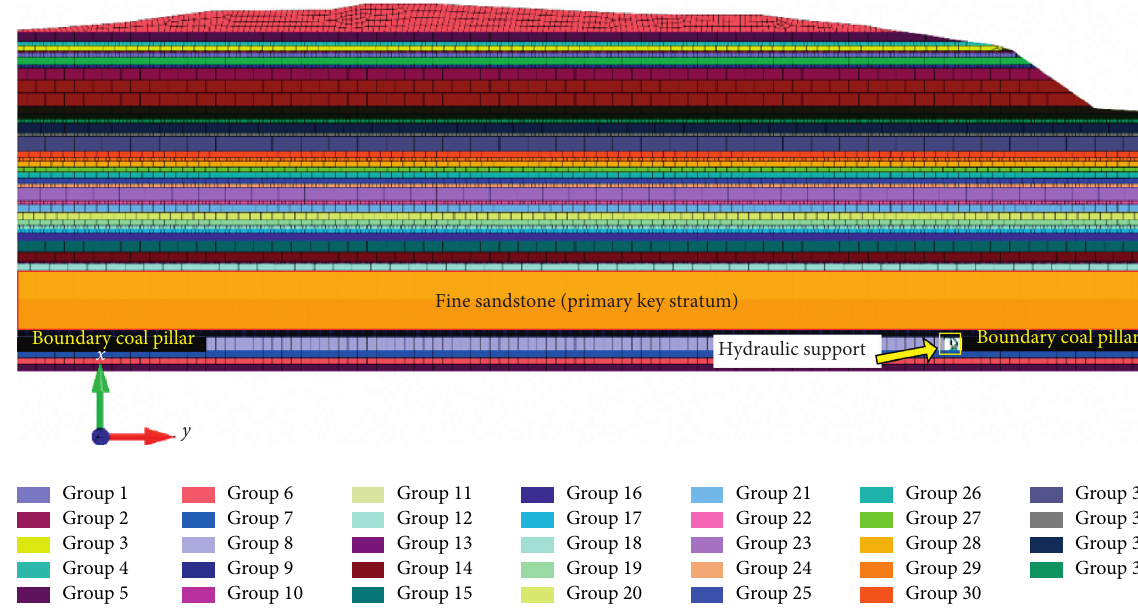
Figure 13: Numerical simulation.